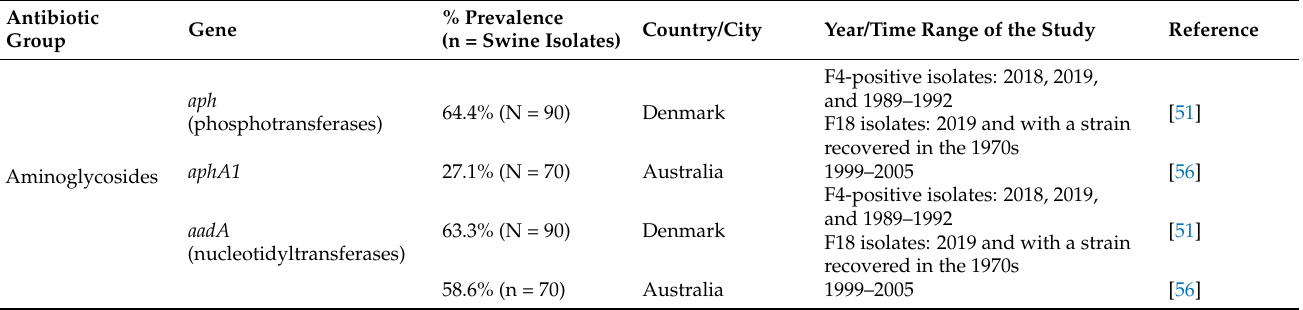
Table 5. The prevalence of resistance genes among the ETEC isolates from swine over the world. Antibiotic